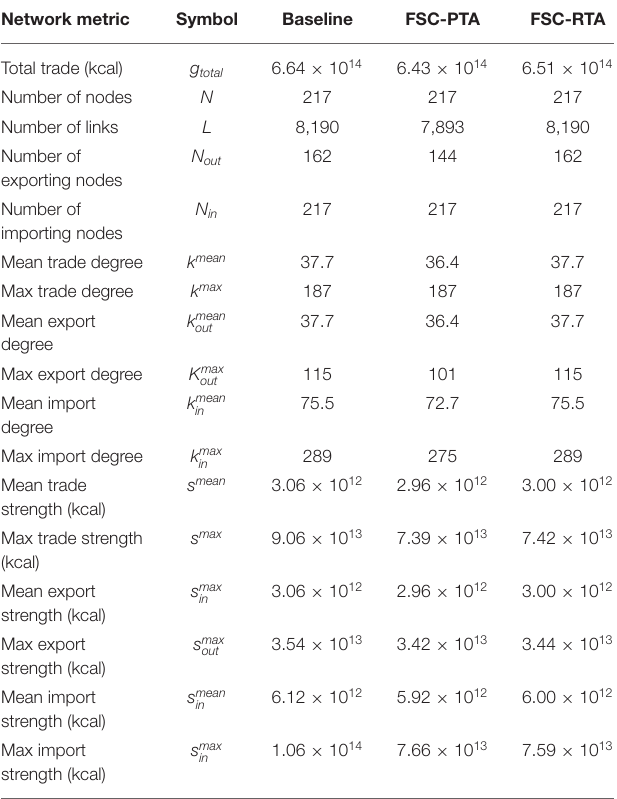
TABLE 2 | Global wheat network metrics for the baseline state and after 4 years of simulation for the FSC-PTA model and the FSC-RTA model. Network